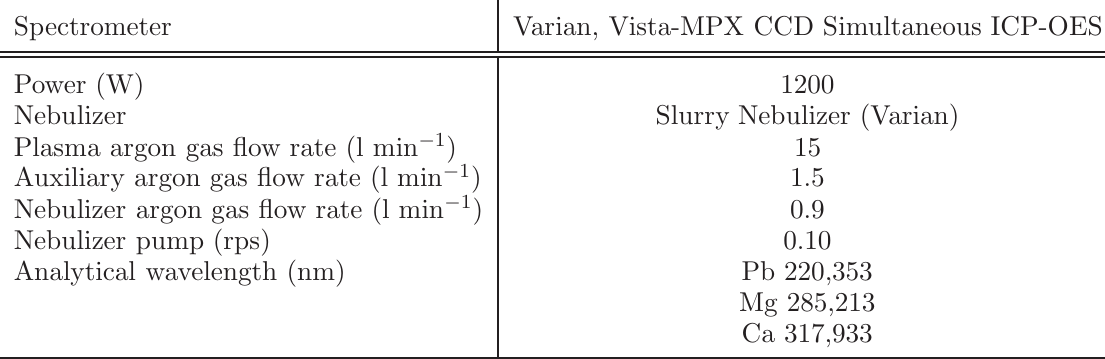
Table 1 Instrumental operating